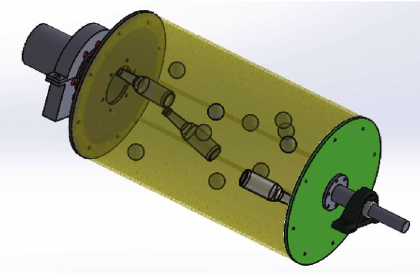
Figure 17: Model for motion simulation.